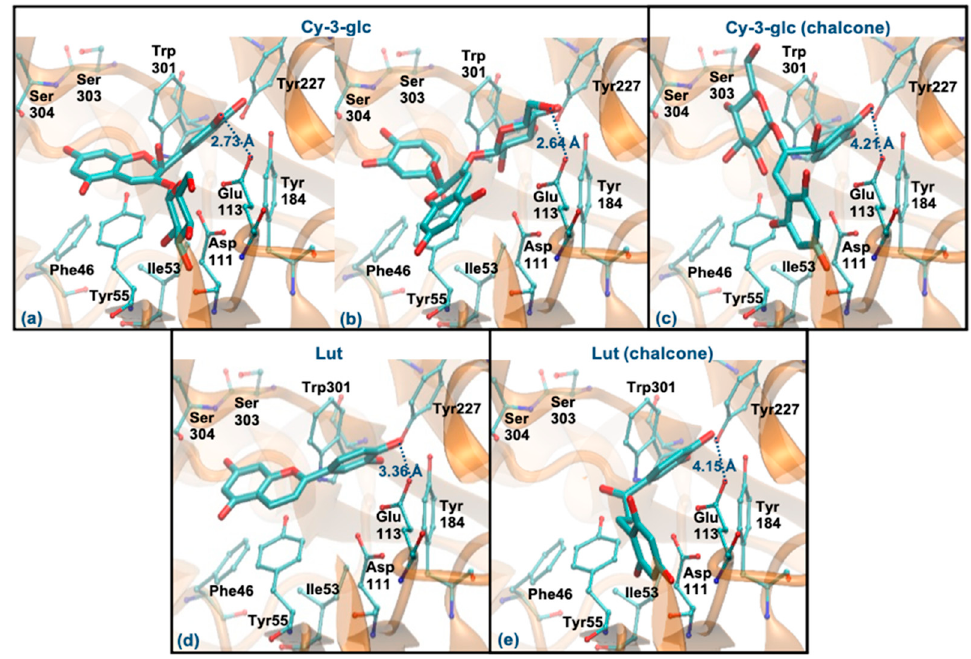
Figure 7. Representation of the structure of hyaluronidase complexed with Cy-3-glc—pseudobase carbinol (interaction by ring B—( a ), interaction by glucose—( b )) and chalcone (interaction by ring B—( c ))—and Lut–pseudobase carbinol (interaction by ring B—( d )) and chalcone (interaction by ring B—( e ))—showing the interacting residues of the active site. The enzyme is depicted in cartoon and colored in orange, the ligands are represented with sticks and colored by atom type, whilst the interacting residues are depicted in ball-and-sticks and colored by atom type. Hydrogen atoms are not represented to simplify the visualization.